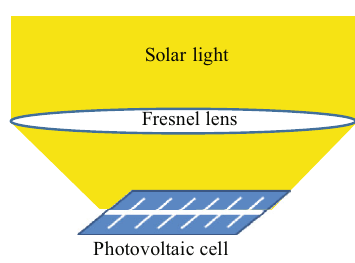
Figure 6: Fresnel light concentration system.